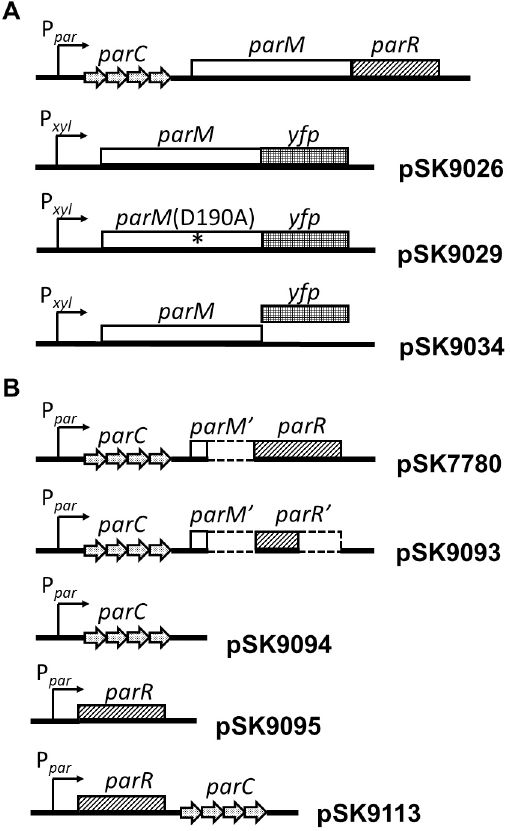
Fig 1. Genetic structures of the pSK41 parMRC operon and parM plasmids (A), and parRC plasmid constructs generated in this study (B). parM is shown as an open box, parR is shown as a cross-hatched box, and yfp is shown as gridded box. Repeats at parC are shown as stippled arrows. P par and P xyl are shown as arrows indicating the direction of transcription. Deleted sequences are denoted by dashed lines. The approximate location of the mutation in parM-yfp of pSK9029 that results in a D190A substitution is indicated by an asterisk. See text for details of plasmid construction. Diagrams are not to